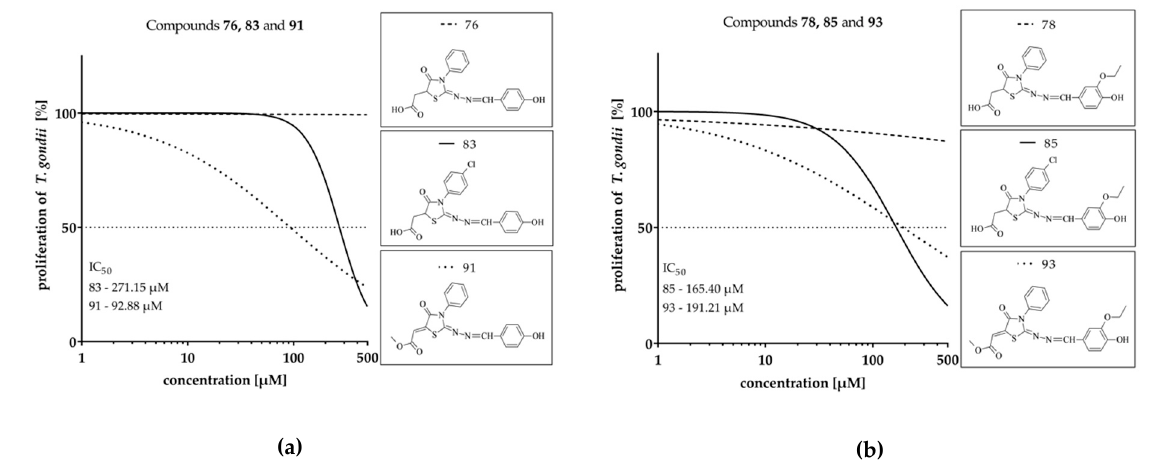
Figure 3. ( a ): Dose response curves and IC 50 values ( μ M) of 76, 83 , and 91 on T. gondii proliferation. ( b ): Dose response curves and IC 50 values ( μ M) of 78, 85 , and 93 on T. gondii proliferation.